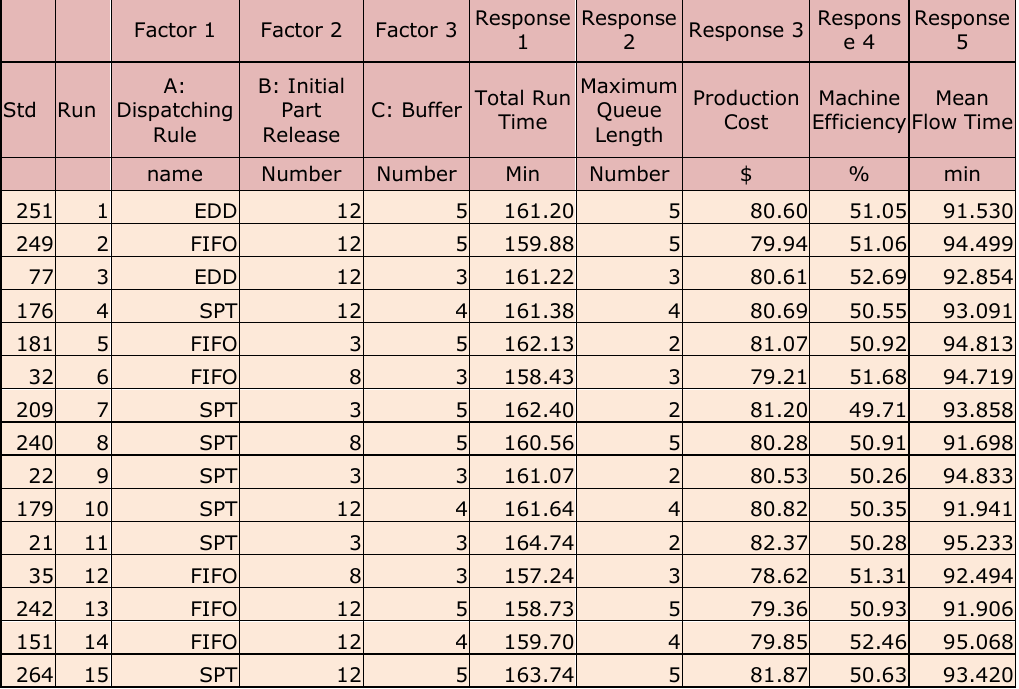
Table 6. Partial results from the main simulation model